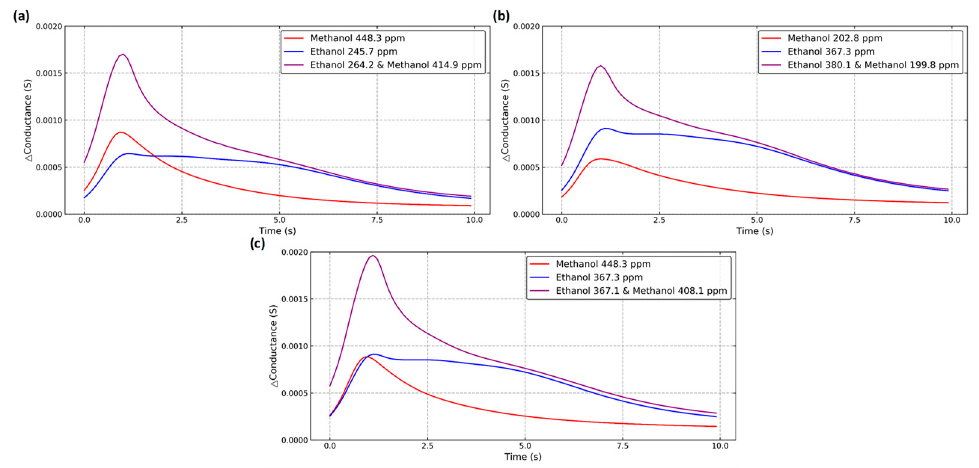
Figure 5. Dynamic response with ( a ) methanol and ( b ) ethanol.